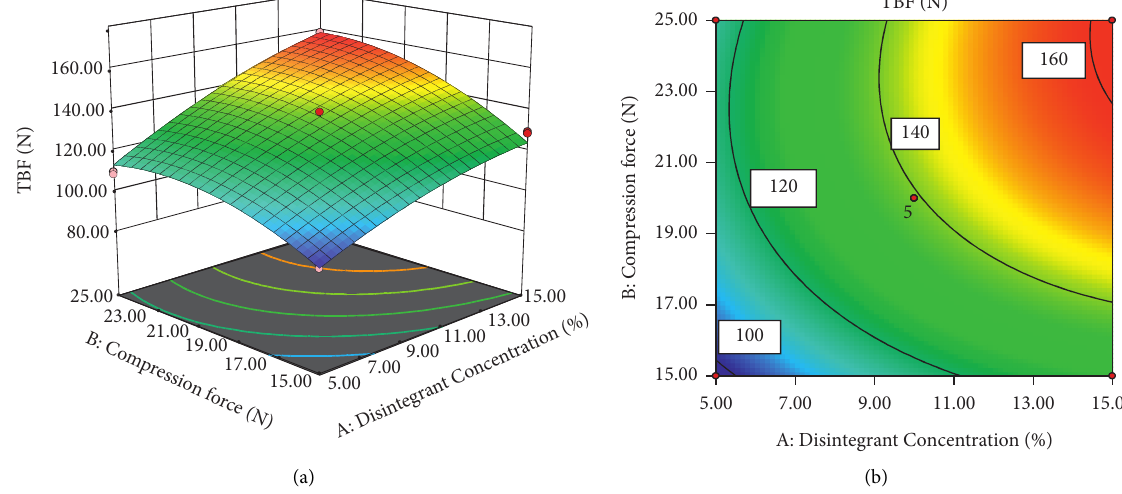
Figure 2: Response surface (a) and contour plots (b) of TBF as a function of compression pressure and